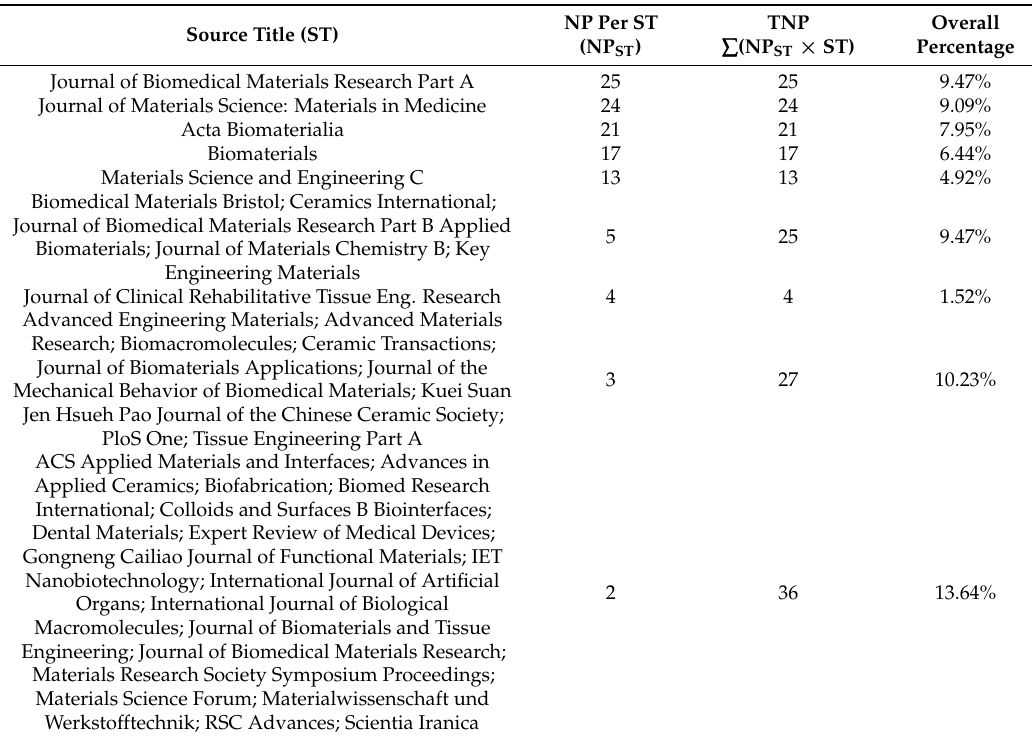
Table 5. Source titles with bucketing regarding the number of publications for A